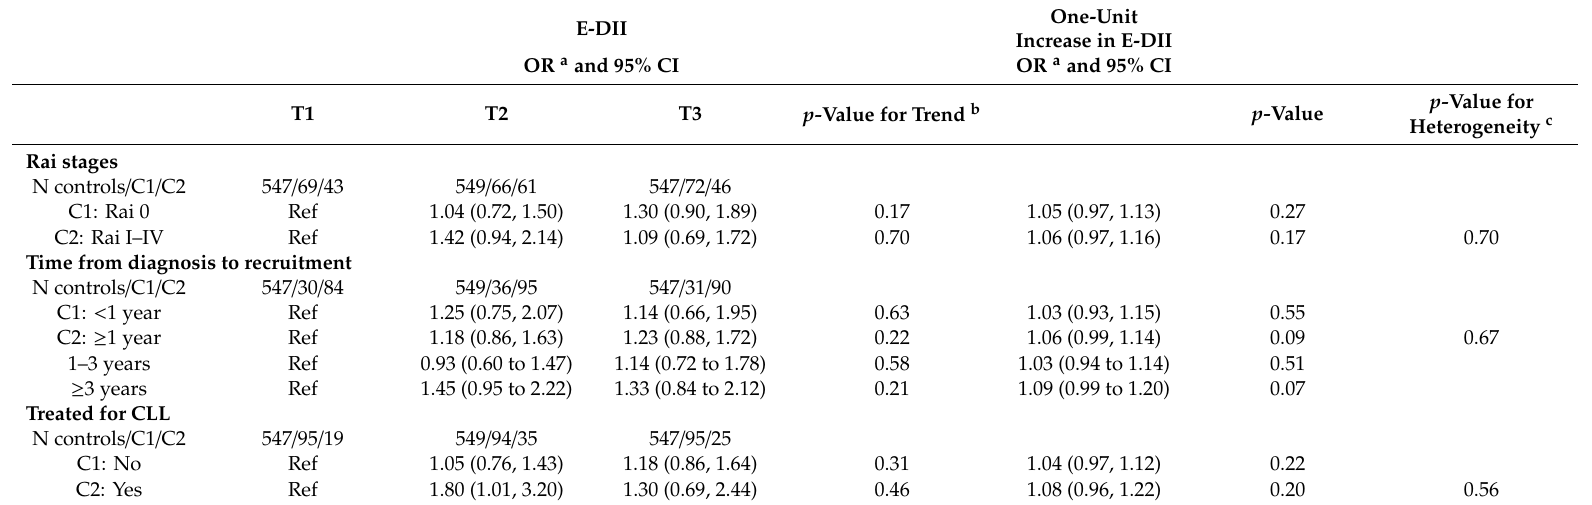
Table 3. Association between the energy-adjusted dietary inflammatory index and chronic lymphocytic leukaemia by severity of disease, time from diagnosis to recruitment and CLL treatment in the multicase-control (MCC) Spain